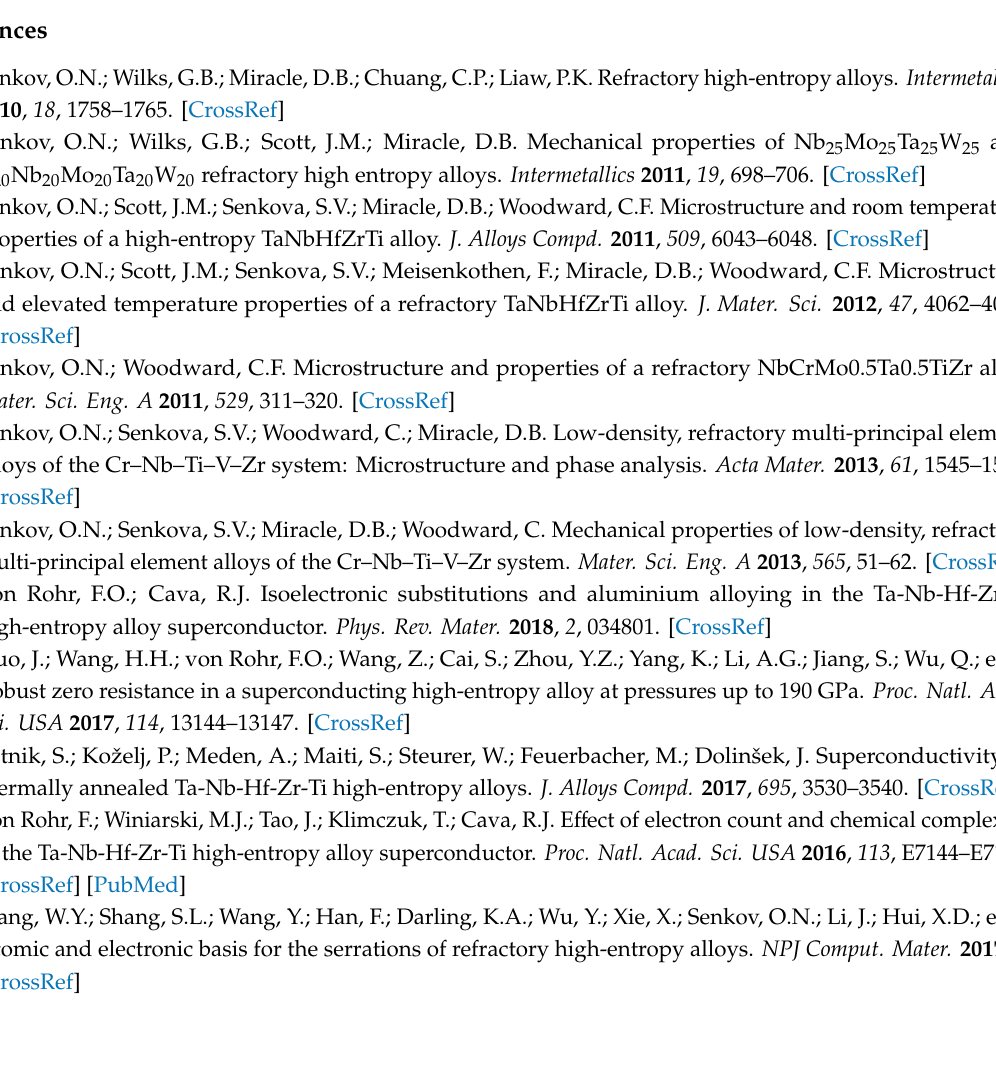
di ff erent magnifications. Figure S6. Statistical analysis of the hcp precipitates in the 1073 and 1273 K-annealed RHEAs. (a) The hcp precipitates of 1073 K-annealed RHEA; (b) the hcp precipitates of 1273 K-annealed RHEA. The sizes of the hcp precipitates are measured by line-intersection method from TEM images. Size distribution of the hcp precipitates in (c) the 1073 K-annealed RHEA, and (d) the 1273 K-annealed RHEA. The red curves were obtained by Gauss fitting. The fitted average sizes of the hcp precipitates in the 1073 and 1273 K-annealed RHEAs are 153 ± 13 nm and 174 ± 4 nm, respectively. Figure S7. Number densities and average sizes of the hcp precipitates in the 1073 and 1273 K-annealed RHEAs. The number densities are calculated by the precipitate number normalized by the observed area in TEM images. Figure S8. TEM observations of 1273 K-annealed HEA. (a) TEM bright-filed image of the second phase without tension deformation, the inset is the selected area di ff raction of matrix and second phase; (b) The high-resolution TEM (HRTEM) image; (c) HRTEM image of the matrix and the hcp phase. Red and yellow squares represent the matrix and the hcp phases respectively; (d) Bright-filed image of the hcp particle after plastic deformation. The hcp phase is surrounded by dense dislocation plug. The inset further shows the dense dislocation